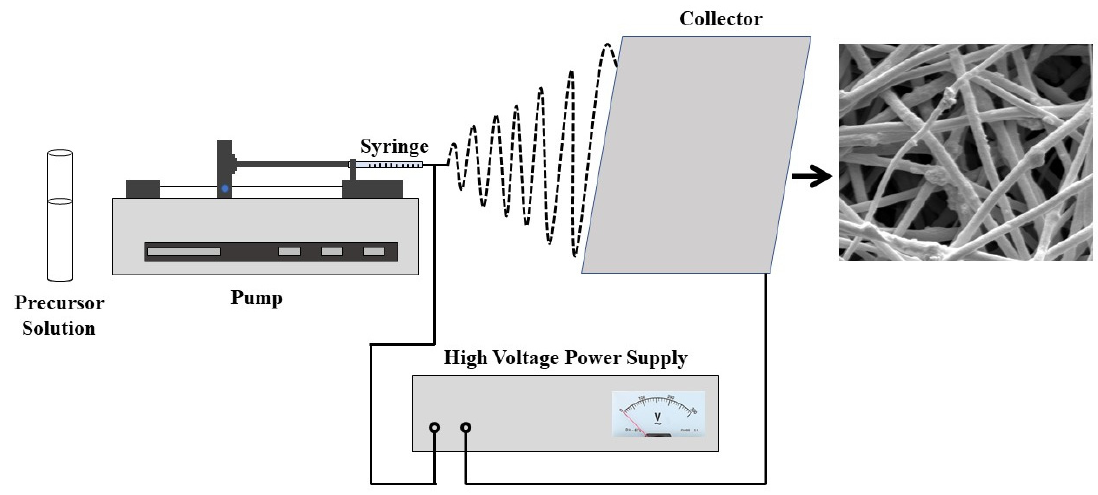
Figure 1. Schematic illustration of electrospinning process.